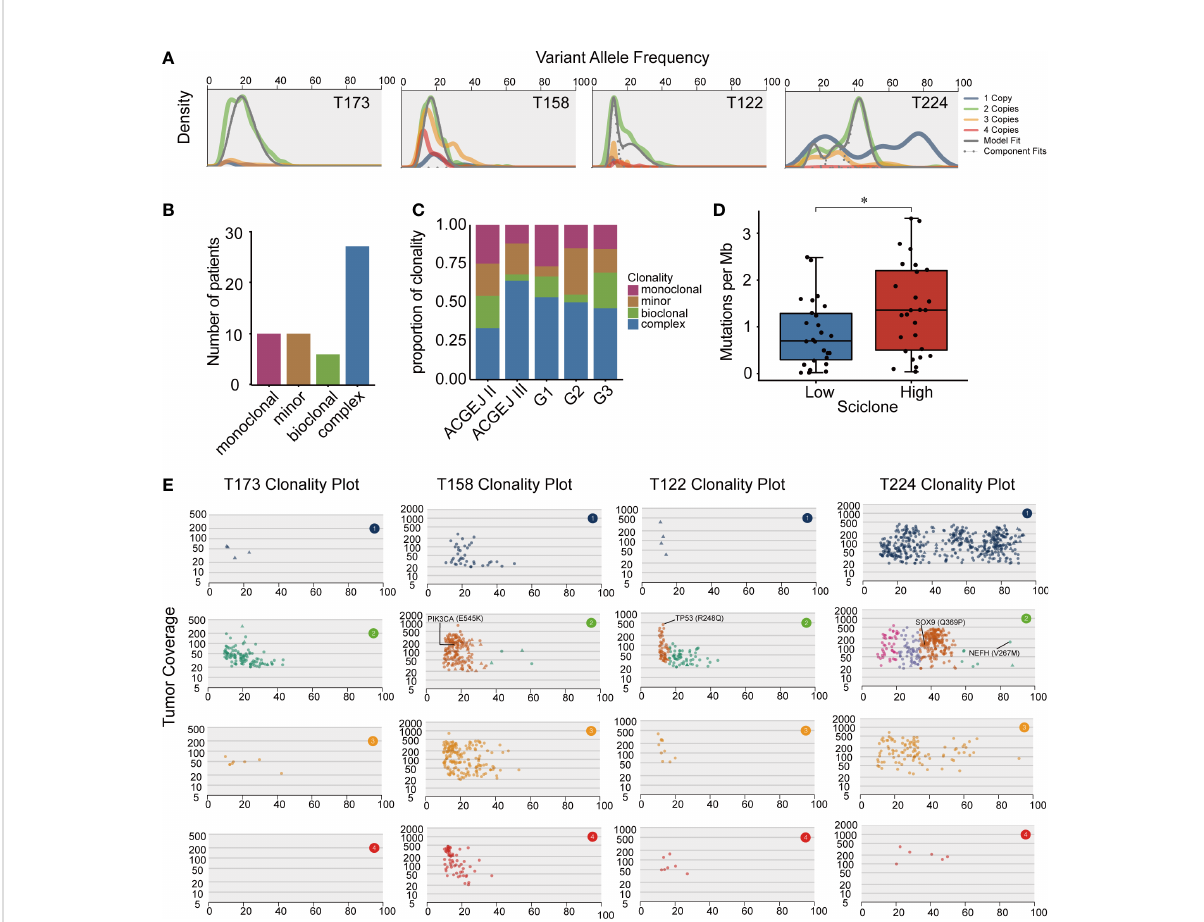
FIGURE 3 The clonal and subclonal architectures inferred in our ACGEJ samples. (A) Kernel density plots of variant allele frequency (VAF) across regions with one, two, three or four copies, posterior predictive densities summed over all clusters for copy-number-neutral variants and posterior predictive densities for each cluster/component. (B) Clonal patterns of 53 ACGEJ samples. (C) The distribution of clonal patterns across histopathological subtypes. ACGEJ II: Siewert type II, ACGEJ III: Siewert type III, G1: well differentiated, G2: moderately differentiated, G3: poorly differentiated or undifferentiated. (D) Comparison of TMB between patients with low and high intratumor heterogeneity de fi ned by clonal patterns. (E) VAFs versus tumor coverage for each of the four copy number regions for four representative samples: T173, T158, T122 and T224. Mutations in previously reported driver genes are labelled. Statistical signi fi cance was described as follows: *P <